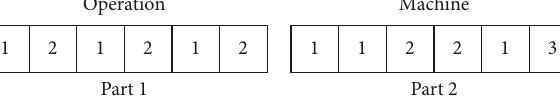
Figure 4: Chromosome